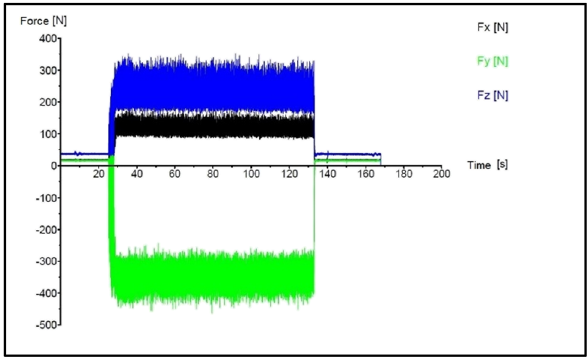
Figure 8: Forces on the permanent magnet tool ( HSS - M ) : F x : radial force, F y : shear force and F z : advance